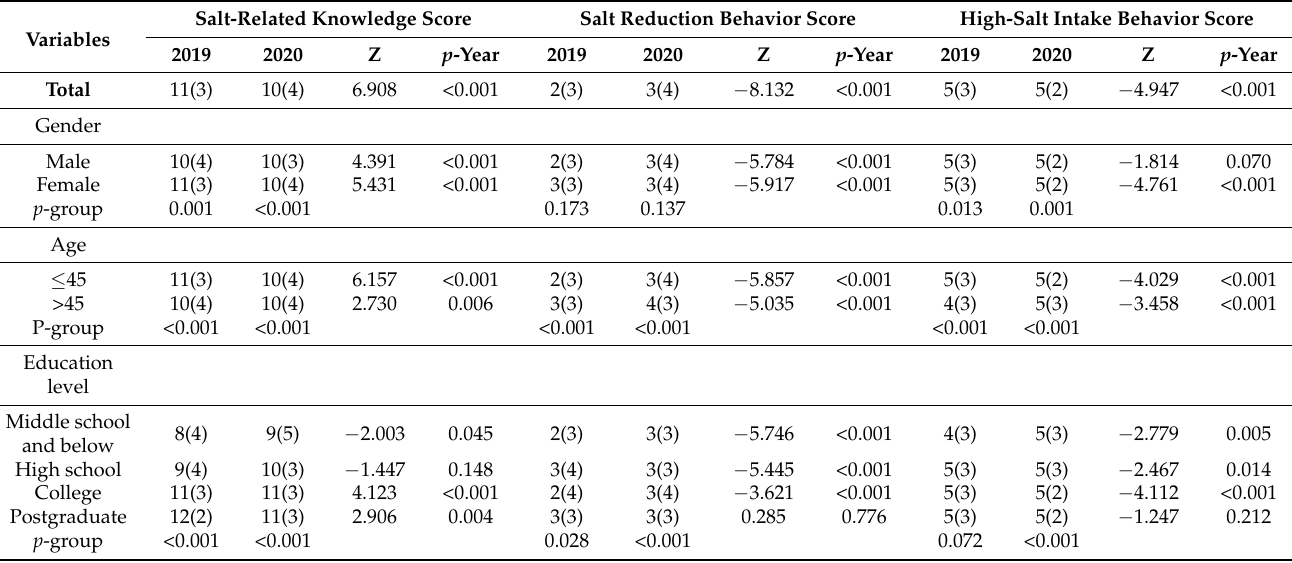
Table 3. Distribution of salt-related knowledge and behavior scores in 2019 and 2020 (Median (IQR)).